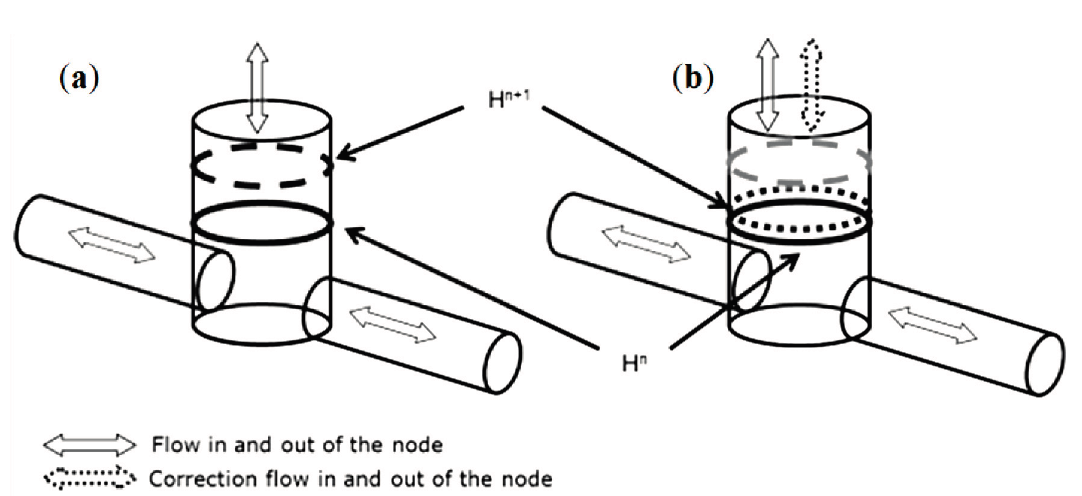
Figure 1. Normal ( a ) HD node computation and ( b ) Update node computation. In this example, the correction flow extracts the volume of water necessary to lower the water level from the level corresponding to the dashed circle to the level corresponding to the dotted